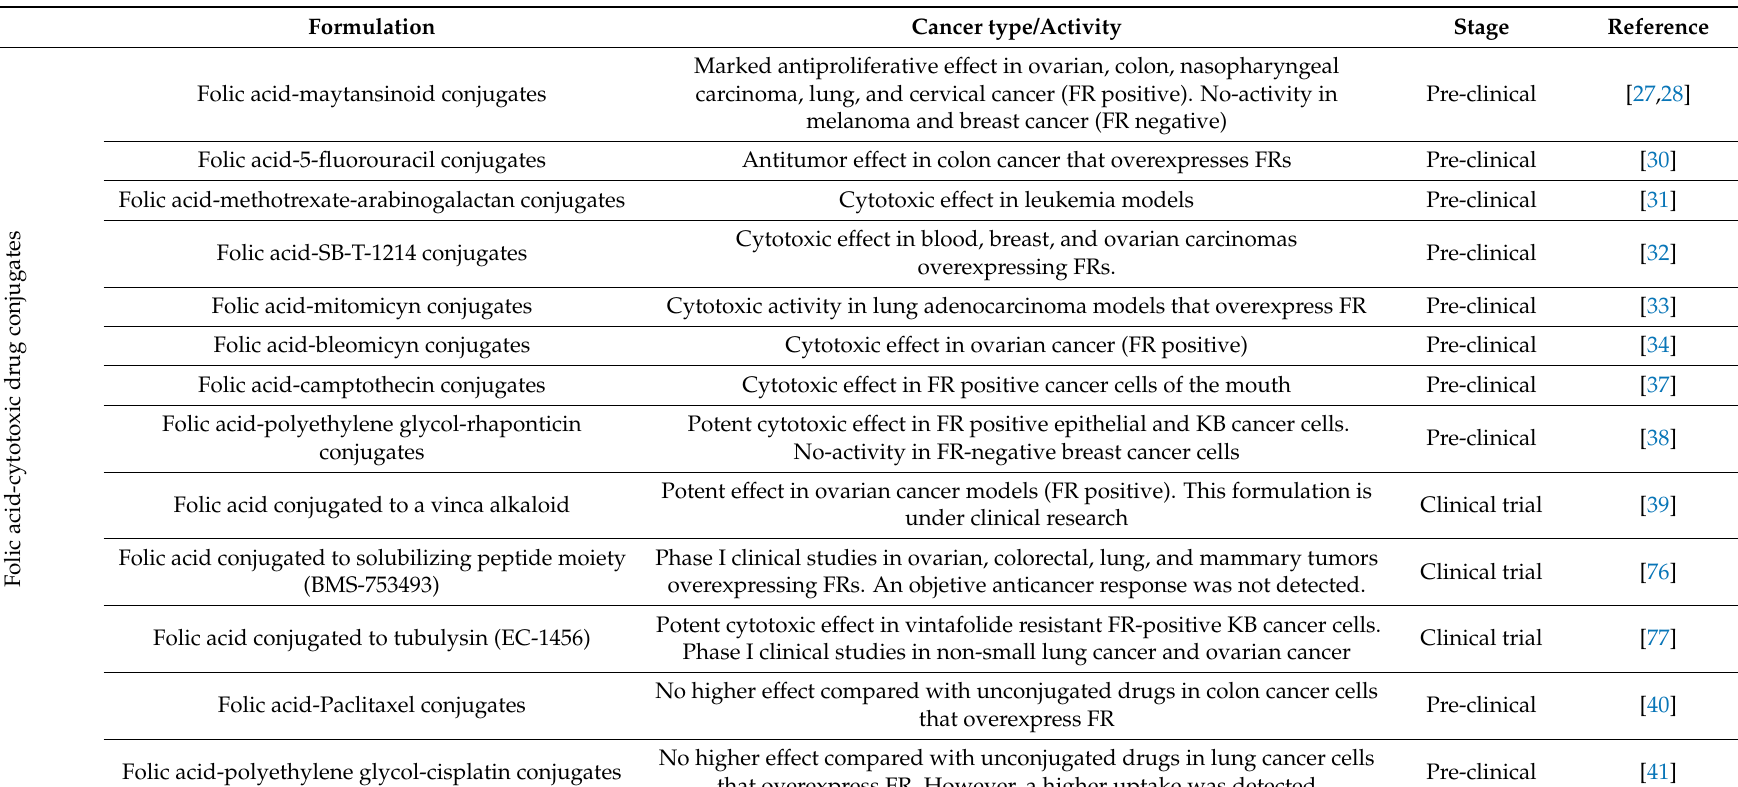
Table 1. FR-targeted nanoformulations designed for cancer